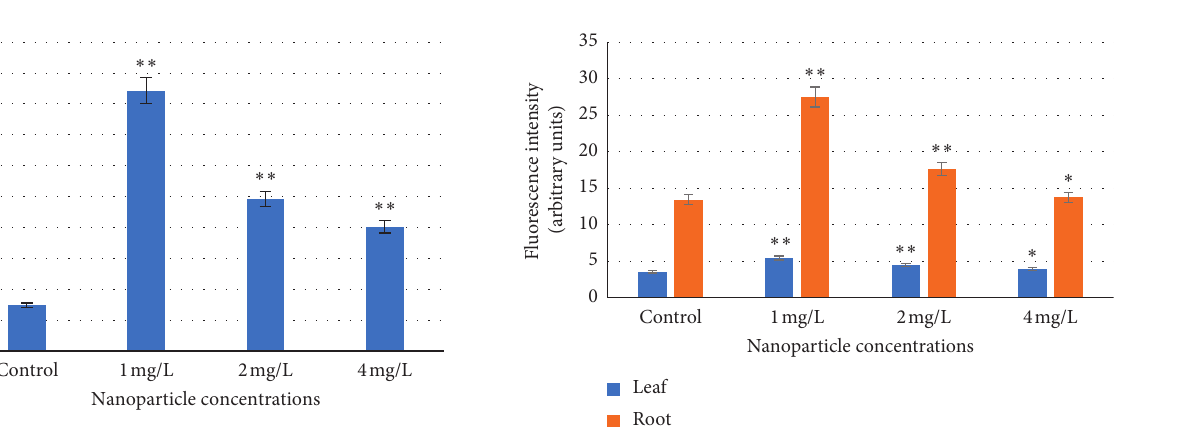
Figure 3: Evans blue dye exclusion assay: cytotoxicity of ZnO NPs in roots of H. vulgare L. seedlings. Values are the mean of three replicates with SD. ∗∗ indicates significant difference from control ( p < 0 .